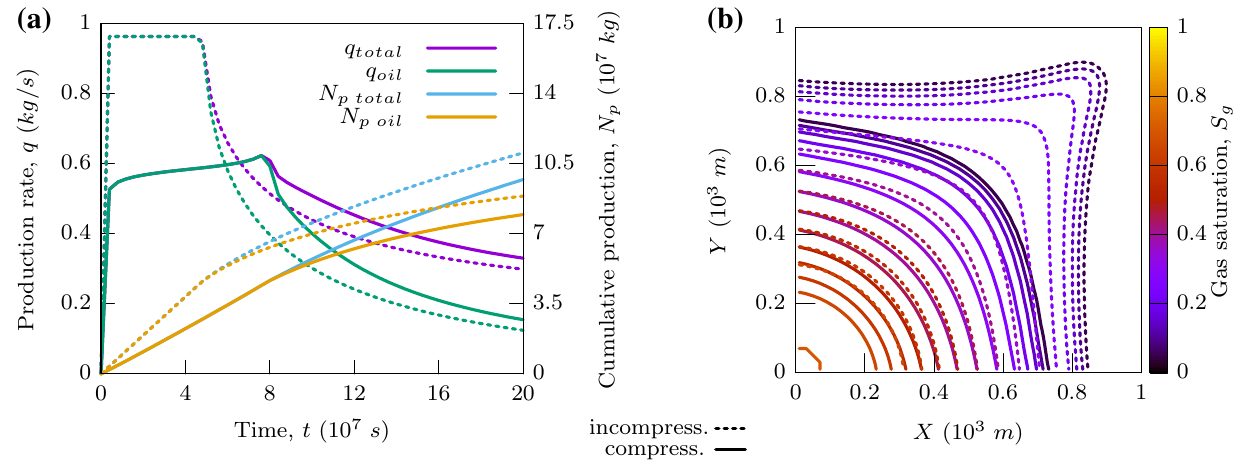
Fig. 7 Injectant gas CO 2 . 2D model. Scenario 1. Comparison of compressible and incompressible cases. a Production profile. b Saturation pro- 4.5 × 10 7 file for